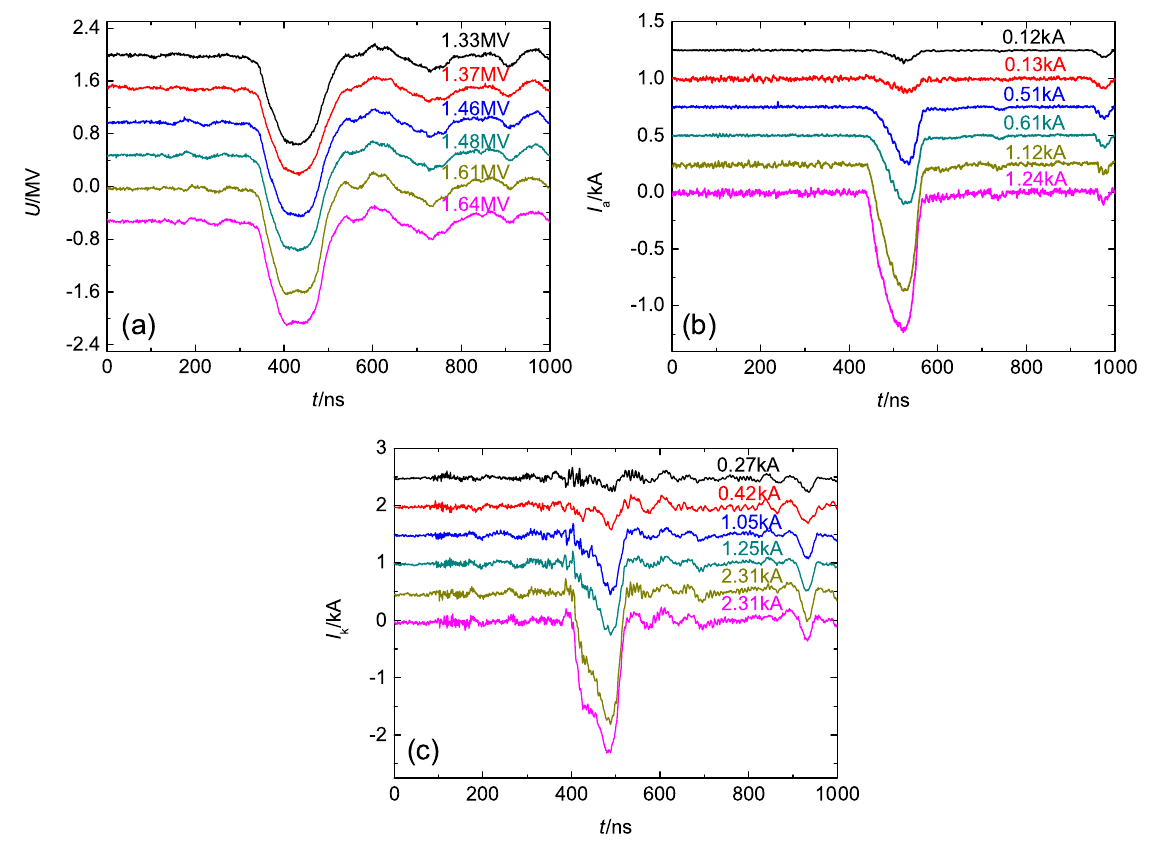
FIG. 4. Typical waveforms of the voltages and the currents: (a) diode voltages, (b) anode currents, and (c) cathode currents.